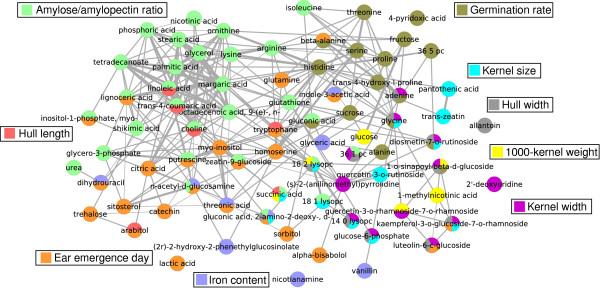
Correlation network of the trait-associated metabolites. The color of the nodes indicates the trait with which they are associated. Thickness of the edges indicates strength of correlation.